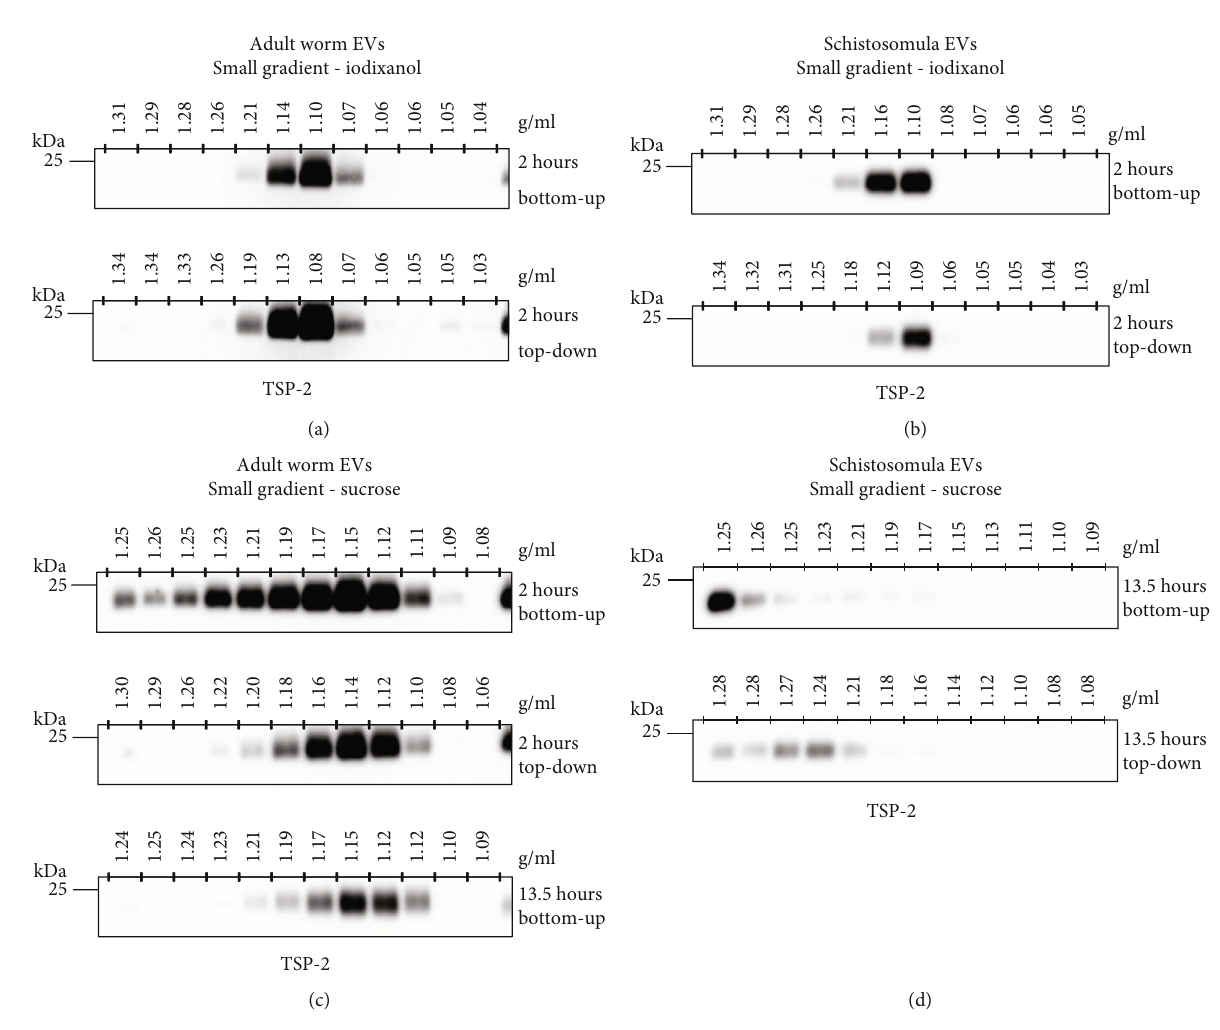
Figure 3: Iodixanol gradients are preferred over sucrose gradients for puri fi cation of adult worm and schistosomula EVs. EV-enriched UC pellets of adult worm EVs (a) or schistosomula EVs (b) were loaded at the bottom (bottom-up) or on top (top-down) of a small iodixanol density gradient and centrifuged for two hours. Western blot analysis of collected density fractions for the EV marker TSP-2 shows that both EV types reached equilibrium densities in the small gradients. (c) Adult worm EVs were loaded at the bottom or top of small sucrose density gradients. Shown are western blot detections of TSP-2 in fractions collected from two and 13.5 hours centrifuged sucrose density gradients. (d) Top-down and bottom-up sucrose gradients were used to purify schistosomula EVs. Shown are western blot detections of TSP-2 in fractions collected from 13.5 hours centrifuged gradients. Gradients were loaded with material from 11 or 10ml culture medium from the adult worms or schistosomula, respectively. Western blots shown are representative for 2-3 independent